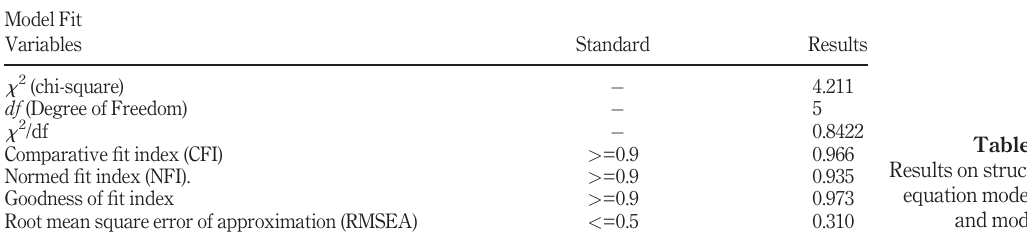
Table 10. Results on